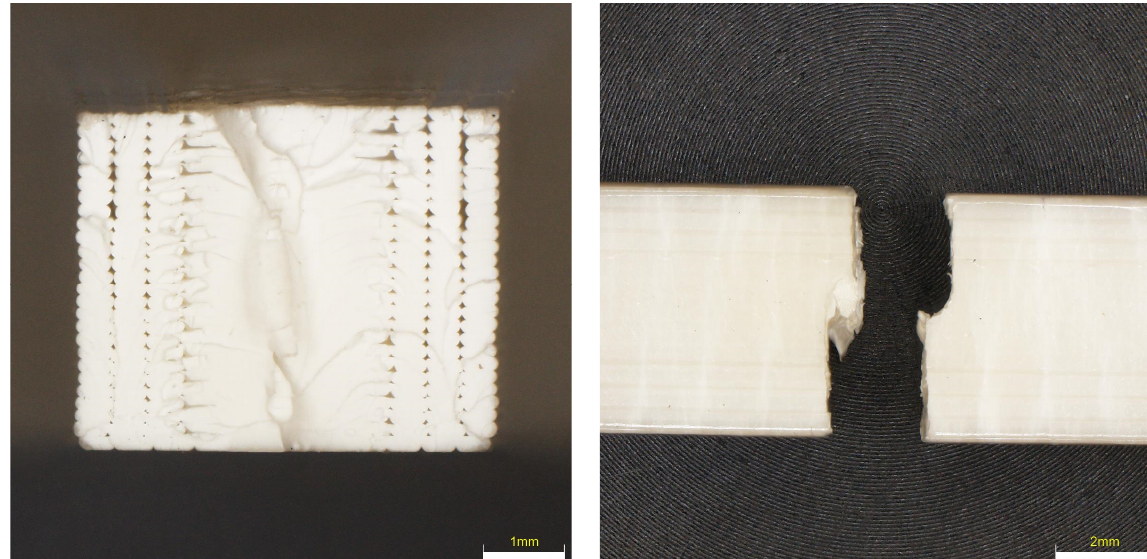
Figure 12. Character of fracture after tensile testing for ABS material.